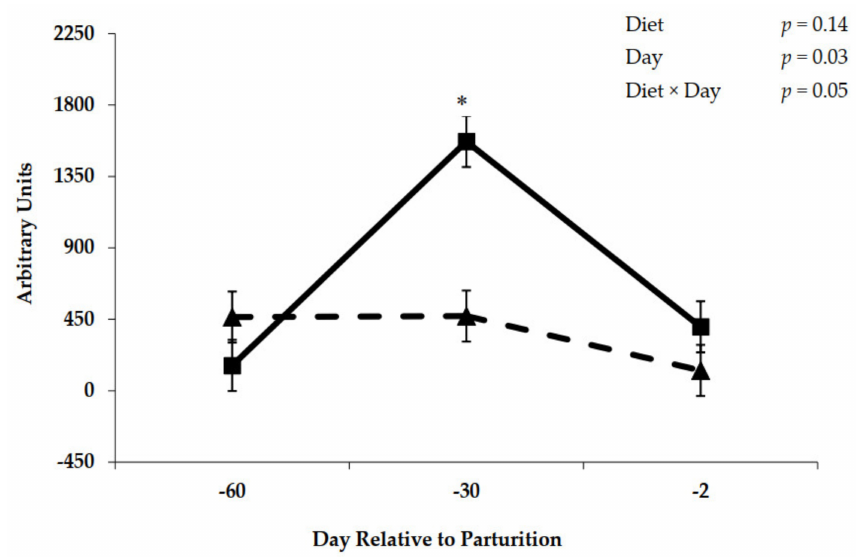
Figure 10. Glucagon-like peptide-2 receptor mRNA expression in rumen epithelial tissue from cows fed control (triangles) or molasses-containing (boxes) diets during the prepartum period. (Error bars = pooled standard error of the mean, Experiment 2, n = 3.) * Within each day, means differ at p < 0.001.